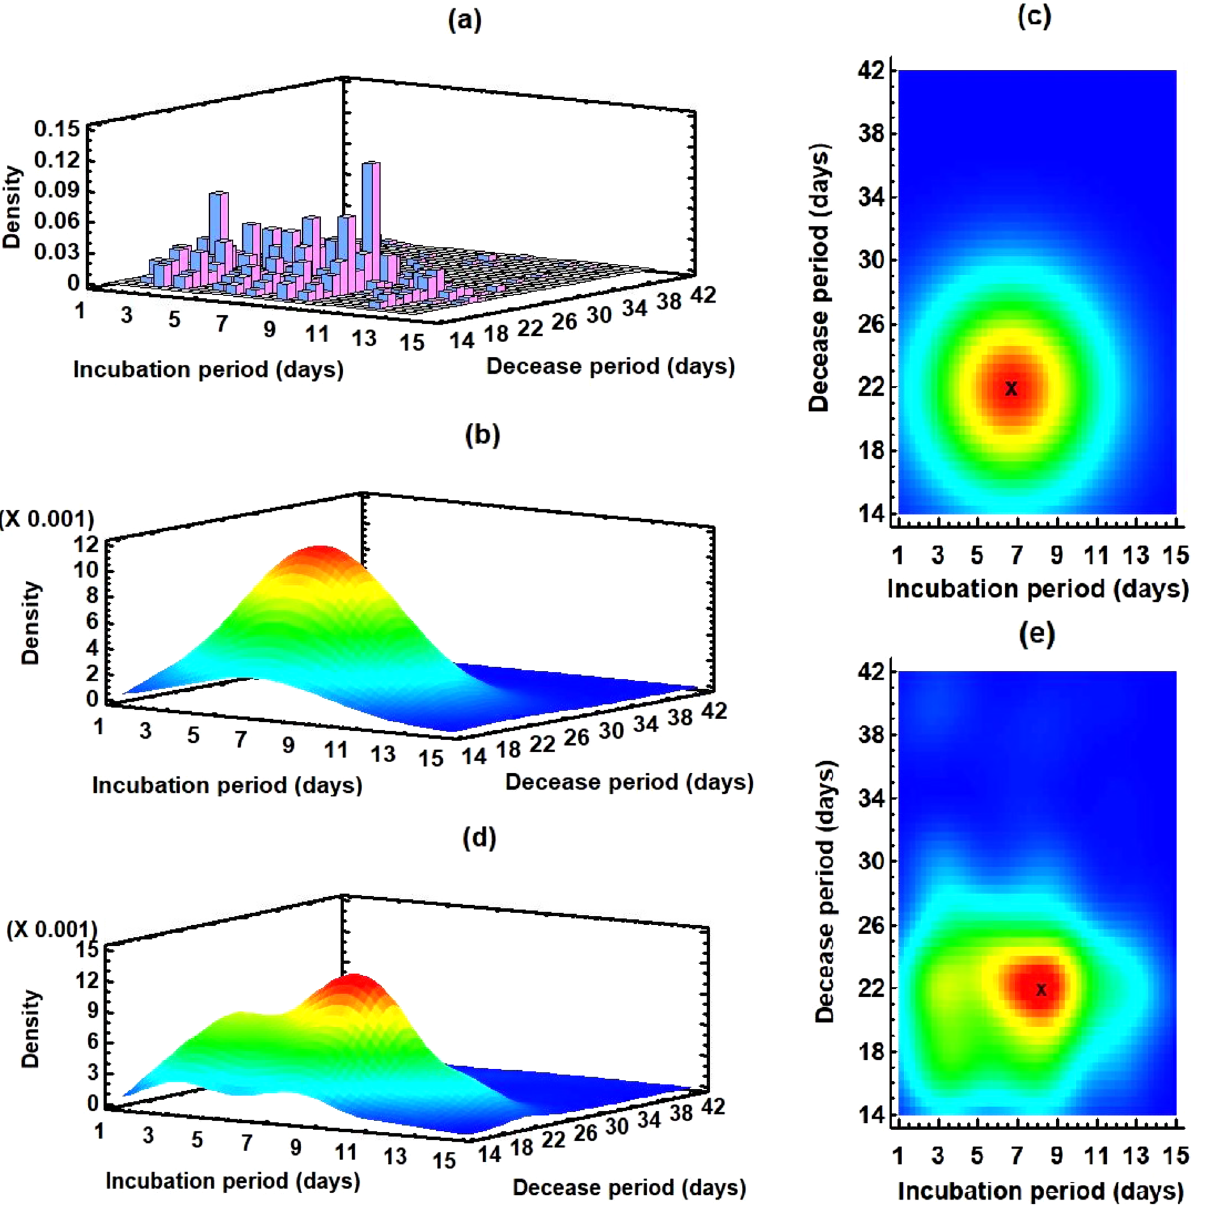
Figure 4. Bivariate distribution of the incubation and decease periods: ( a ) Histogram of the estimated data D ik for i = 1, 2, . . . , 14 and k = 1, 2, . . . , 29 using the model. ( b ) Fitted bivariate normal distribution. ( c ) Two- dimensional display of ( b ); the red region is the highly probable domain for decease, and x (6.56, 21.64) denotes the center of the region. ( d ) Fitted nonparametric density estimate with wide 40%; two peaks show that there are two distinguishable high probable regions. ( e ) Two-dimensional display of ( d ); the x represents the center of the high probable red region (8.17,